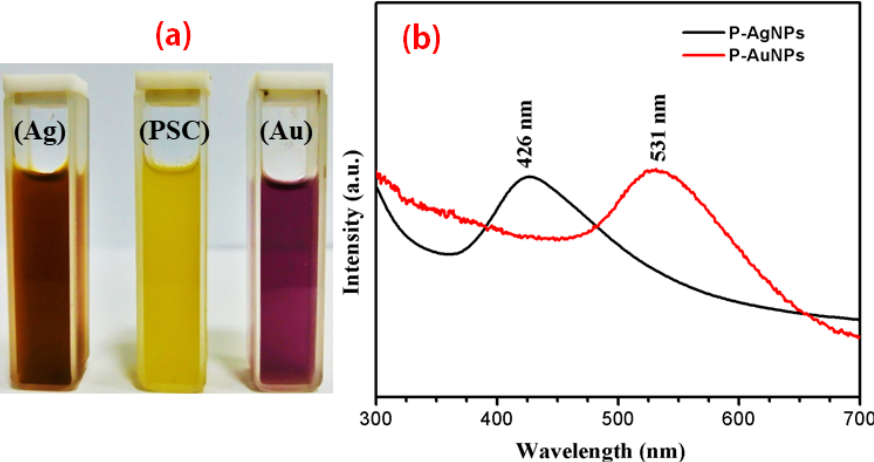
Figure 1. The UV-visible spectra of synthesized nanoparticles. ( a ) Yellowish aqueous PS extract, brown color Ag NPs and pinkish violet Au NPs, respectively, ( b ) UV-visible spectra of Ag NPs and Au NPs.